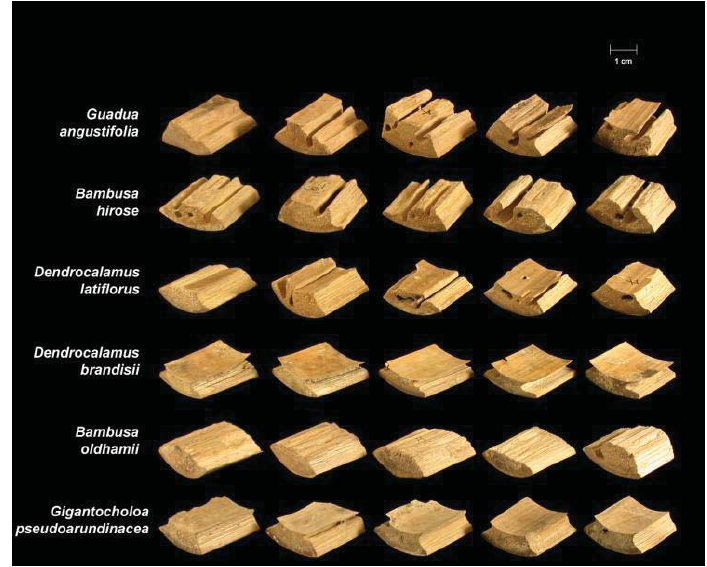
Figure 3. Bamboo blocks showing damage from C. formosanus. Image courtesy of Robert Oshiro.